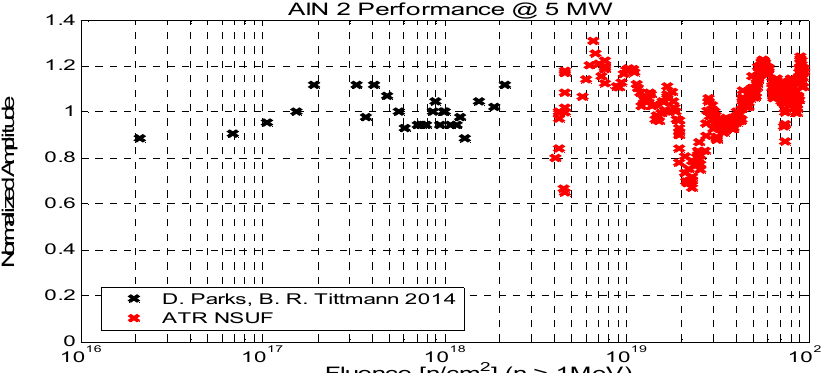
Figure 11. Normalized amplitude of pulse-echo signal showing the results of both the Pennsylvania State University (PSU) TRIGA reactor and the MITR (Massachusetts Institute of Technology Nuclear Research Reactor) measurements. Note that the excursions to low amplitudes are the results of reactor scrams [31].